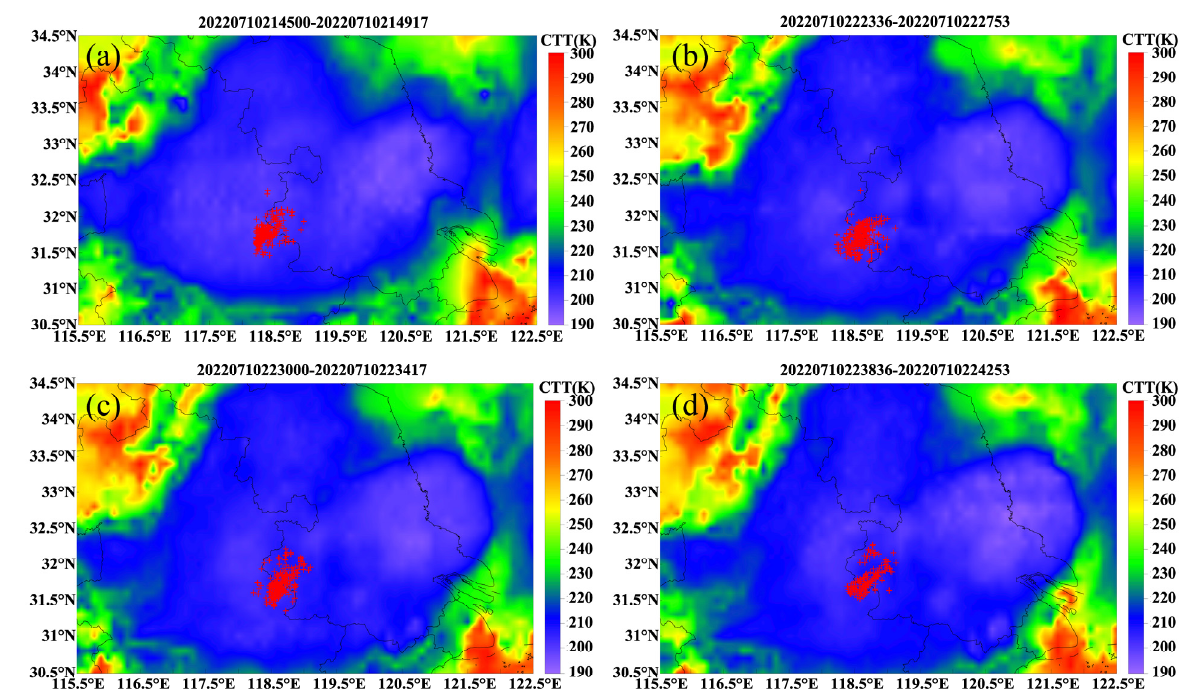
Figure 3. Cloud top temperature (colored) and lightning location (red crosses): ( a ) from 21:45 to 21:49, ( b ) from 22:23 to 22:27, ( c ) from 22:30 to 22:34, and ( d ) from 22:38 to 22:42.